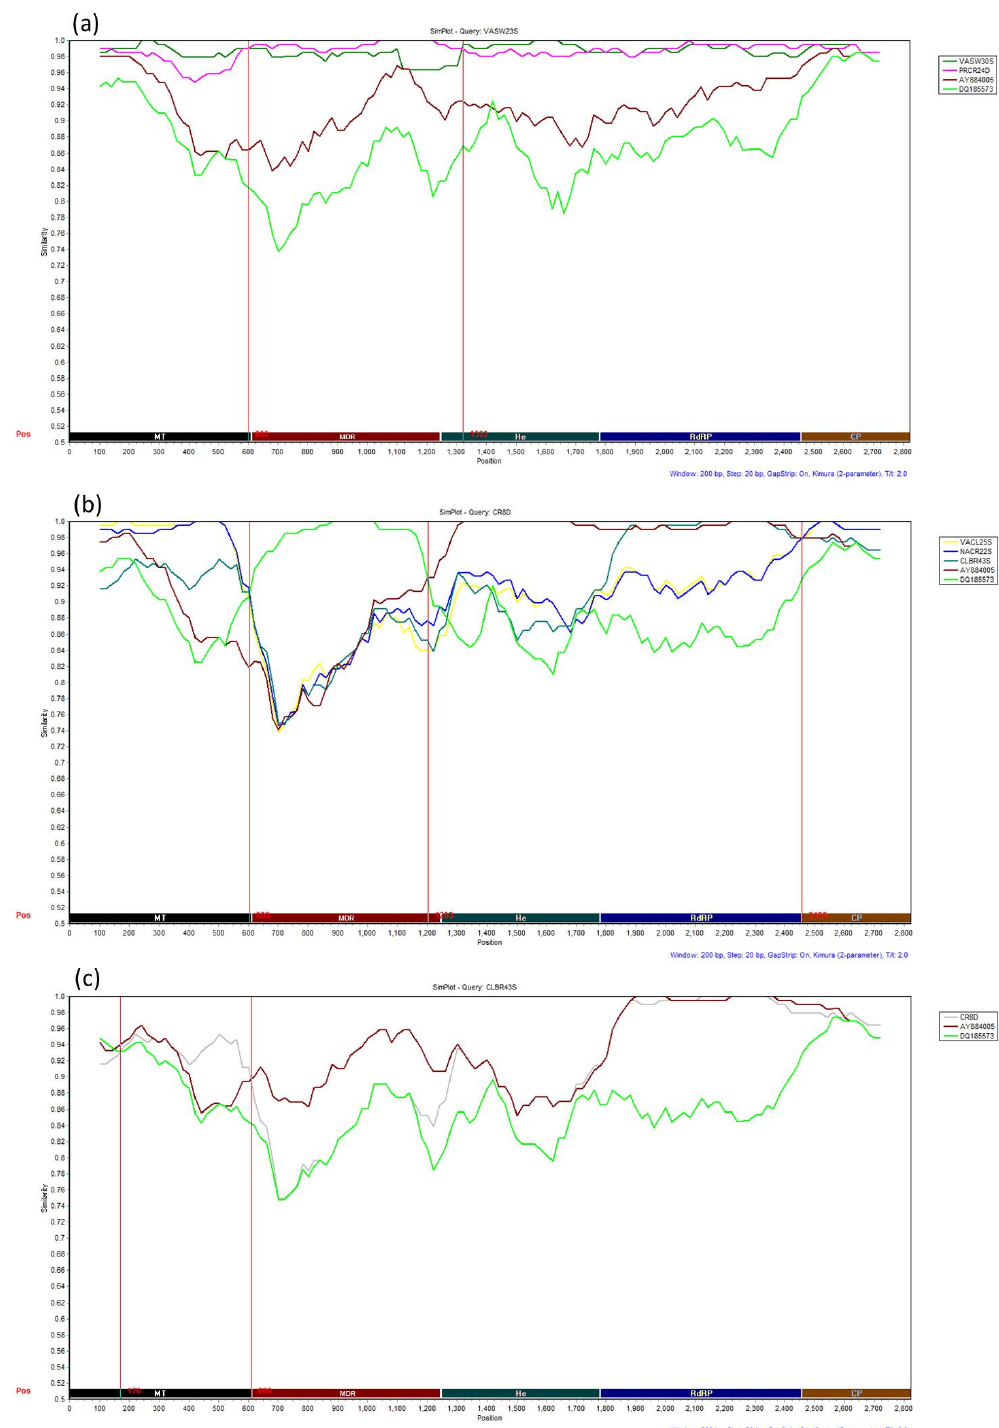
Figure 3. Phylogenetic relationship with potential recombinant CSDaV isolates as the query sequences based on concatenated nucleotide sequences of the MT, MDR, He, RdRP and CP genomic regions using Simplot. Three CSDaV isolates, VASW23S ( a ), CR8D ( b ) and CLBR43S ( c ), were used as query sequences and two CSDaV isolates were used as reference sequences. The Y ‐ axis illustrates variation in identity percentage. Analyses were done using a sliding window of 200 bp and a step size of 20 bp. Red vertical dashed line shows the proposed recombination break point. Sequences compared with the query sequence are indicated in the legend.